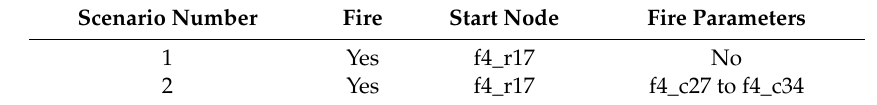
Table 7. Environmental semantics of experiment 3.